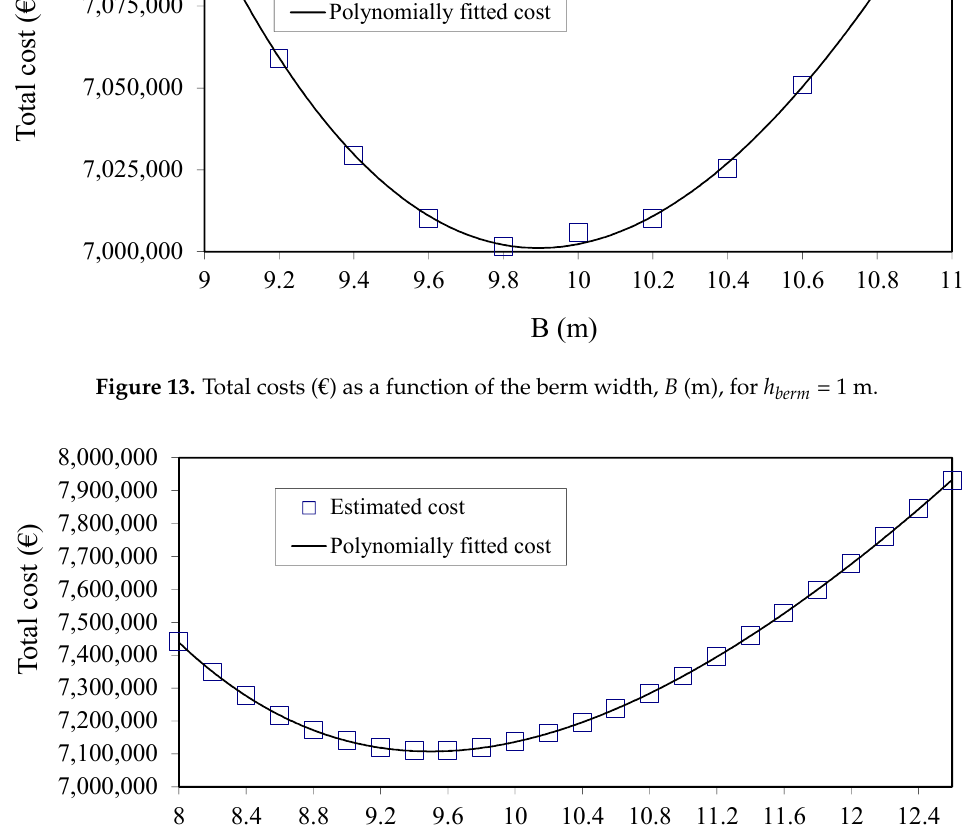
Figure 12. Cross-section of the studied rubble mound breakwater in Deauville, France for mitigation option 3.